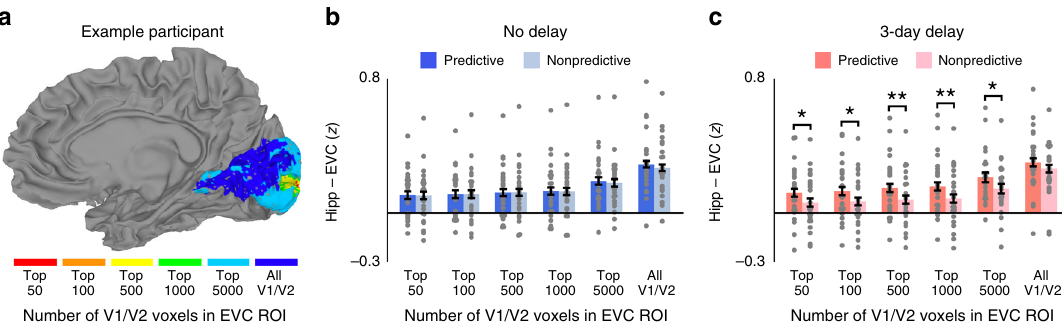
Fig. 3 Speci fi city within V1/V2. a The volume of the EVC ROI was incrementally dilated from including just the 50 voxels most responsive to the experimental stimuli in the functional localizer scan to including all of V1/V2. b Across the full range of ROI sizes, background connectivity was equivalent for predictive and nonpredictive actions after no delay. c After the 3-day delay, background connectivity was stronger for predictive than nonpredictive actions within ROIs that ranged in volume from 50 to 5000 voxels but was not reliably different when all V1/V2 voxels were included in the EVC ROI. Error bars indicate ± 1 SEM of the difference between predictive and nonpredictive actions at each timescale. ** p < 0.01; * p < 0.05 (paired t -tests). Source data are provided as a Source Data fi le